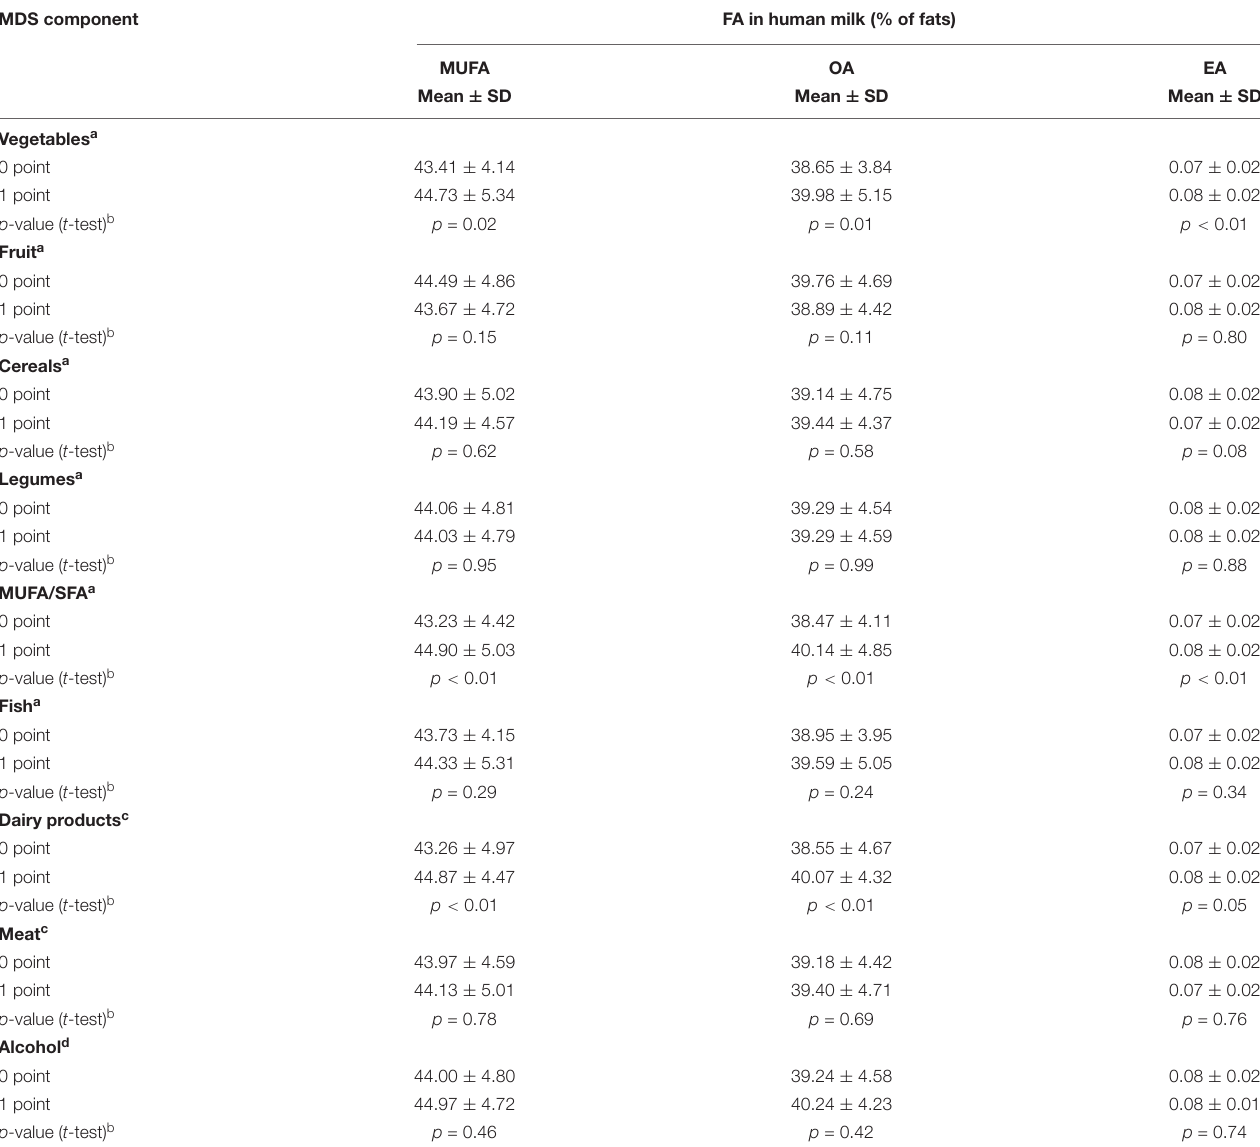
TABLE 5 | Mean and standard deviation contents of major monounsaturated fatty acids in human milk (expressed as% of fats) according to the adherence of breastfeeding mothers to single components of the Mediterranean Diet Score. MDS